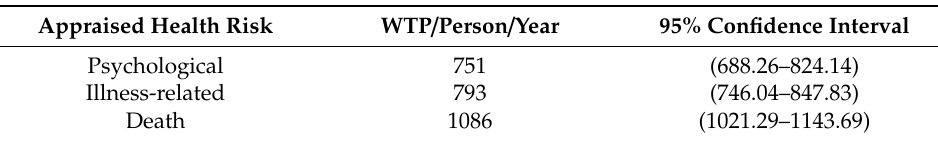
Table 6. Health risks and WTP for dengue